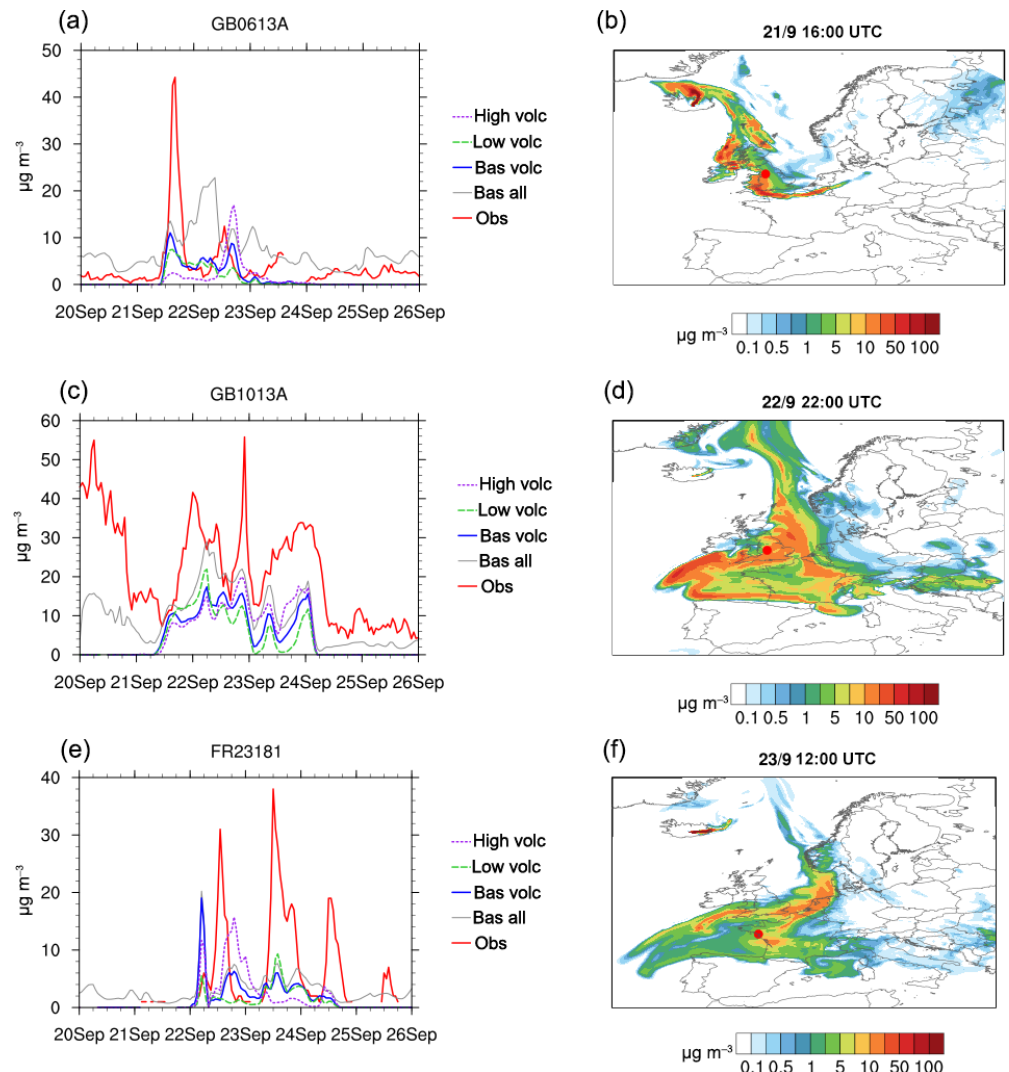
Figure 4. Left panels: time series of surface concentrations from 20 to 26 September 2014 for two stations, GB0613A, Manchester, SO 2 (top), PM 2 . 5 (middle) and FR23181, Saint-Nazaire, SO 2 (bottom). The red line shows the measured surface concentrations, the grey line represents the modelled surface concentration in bas_hol (“bas all”). By subtracting from the modelled surface concentrations in the three model runs (bas_hol, low_hol and high_hol) the no_hol simulation values, the concentration due to volcanic eruption is calculated and shown in the blue, green and pink lines respectively. Right panels: corresponding map of simulated surface concentration due to the volcanic eruption from bas_hol, corresponding to the blue line in the left panels, for the time of the maximum observed concentration. The red dot on the map marks the position of the